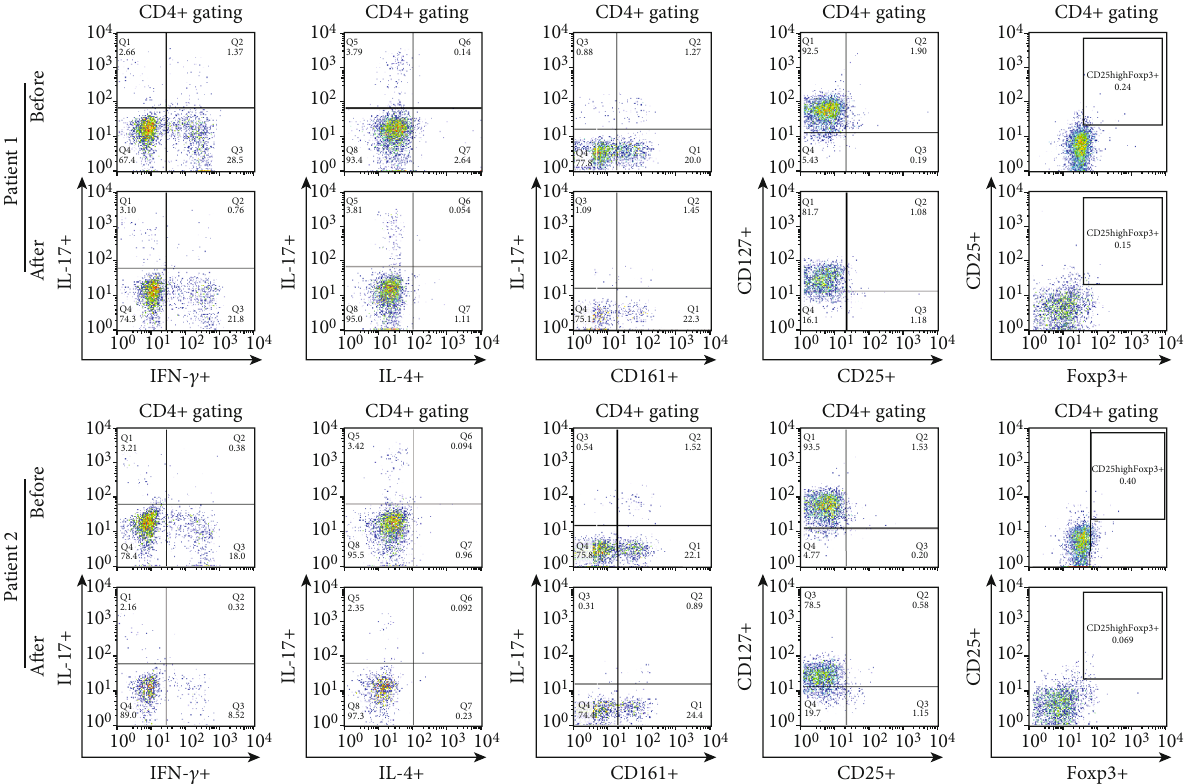
Figure 7: Comparison of Th1, Th2, Th17, and Treg subpopulations in the CD4+ T cell population before and after MSC treatment. PBMCs were stained with anti-CD4 PE-Cy7-conjugated, anti-CD25 APC-conjugated, anti-IFN- γ FITC-conjugated, anti-IL-17 PE-conjugated, anti- IL-4 APC-conjugated, anti-CD161 FITC-conjugated, and anti-Foxp3 FITC-conjugated antibodies. CD4+ T cells were gated for further analysis. The proportions (%) of IFN- γ +/CD4+ T cells, IL-17+/CD4+ T cells, IL-4+/CD4+ T cells, IL-17 +CD161+/CD4+ T cells, CD127lowCD25high/CD4+ T cells, and CD25+ FOXP3+/CD4+ T cells in each patient were determined. “ Before ” indicates the results at the start of MSC treatment, and “ After ” indicates the results at 3 months after the fi nal MSC infusion. MSCs: mesenchymal stem cells; PBMCs: peripheral blood mononuclear